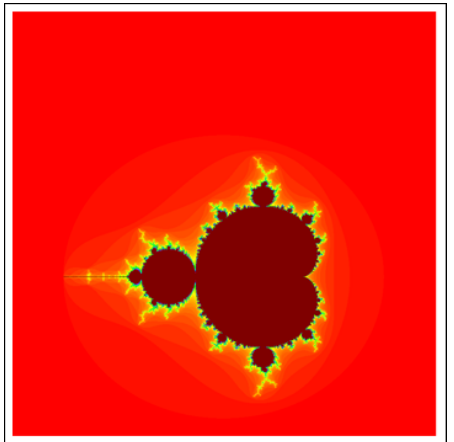
Figure 32. Quadratic M-set via F-iteration with image visual time = 69.3 s.